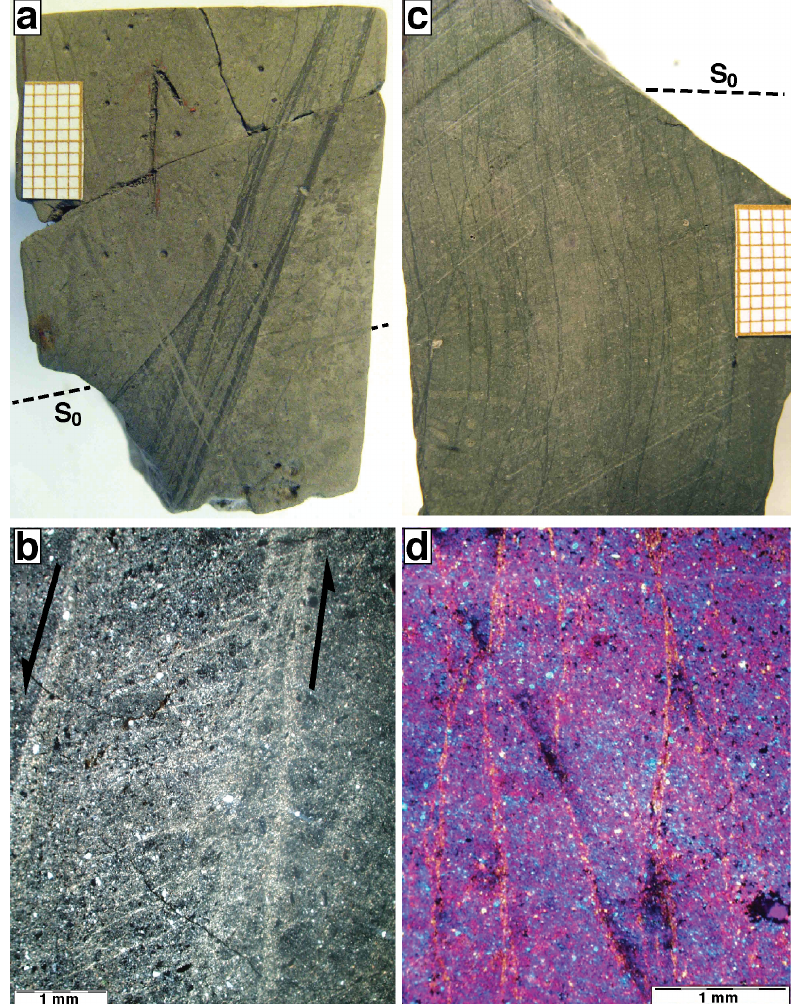
Figure 2. Subvertical deformation bands observed in cores of the NanTroSEIZE transect, showing a darker color than the matrix and a crystal preferred orientation. S0 represents the stratification plane. (a, b) Macroscopic and microscopic (cross-polarized light) views of a shear zone with a normal component of slip (sample C0001 4R-3, 73-76). (c, d) Macroscopic and microscopic (cross-polarized light with a lambda plate) views of anastomosing veins (sample C0001 10R-2, 35-40). Core top is upward in all the pictures. Scale bar is 1cm in macroscopic